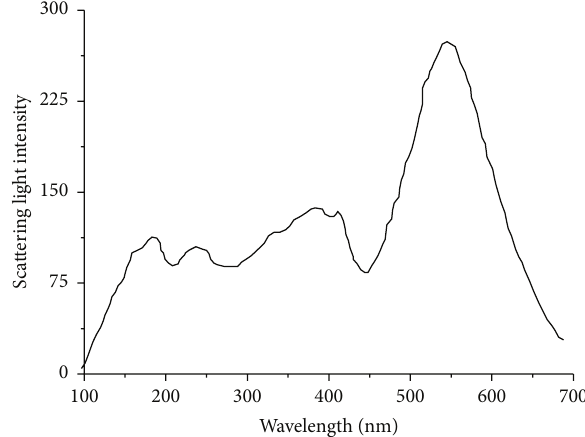
Figure 1: Light scattering spectrum of filamentous tau solution (10 𝜇 M 4RMBD incubated at 37 ∘ C for 5 hr. by the aggregation inducing reagent,